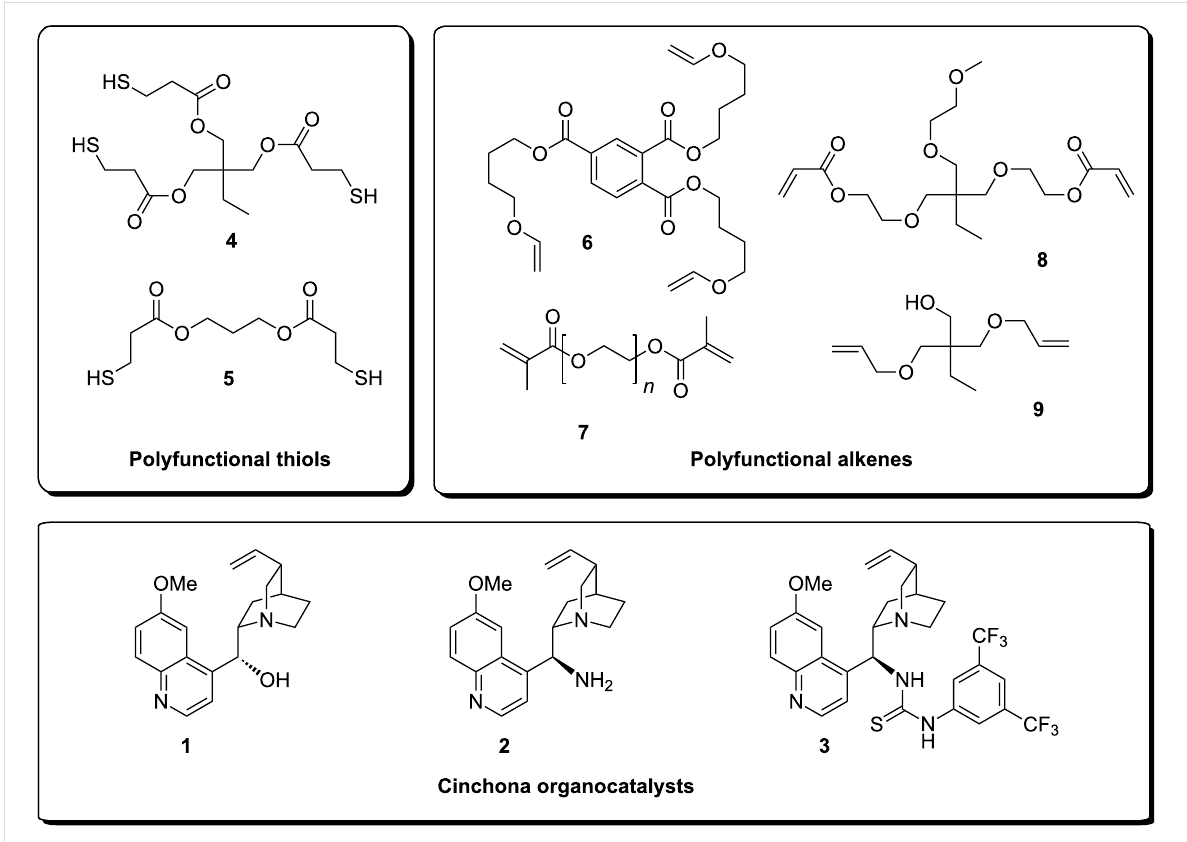
Figure 1: Thiol, alkene and organocatalyst building blocks for combined bead polymerization and Cinchona organocatalyst